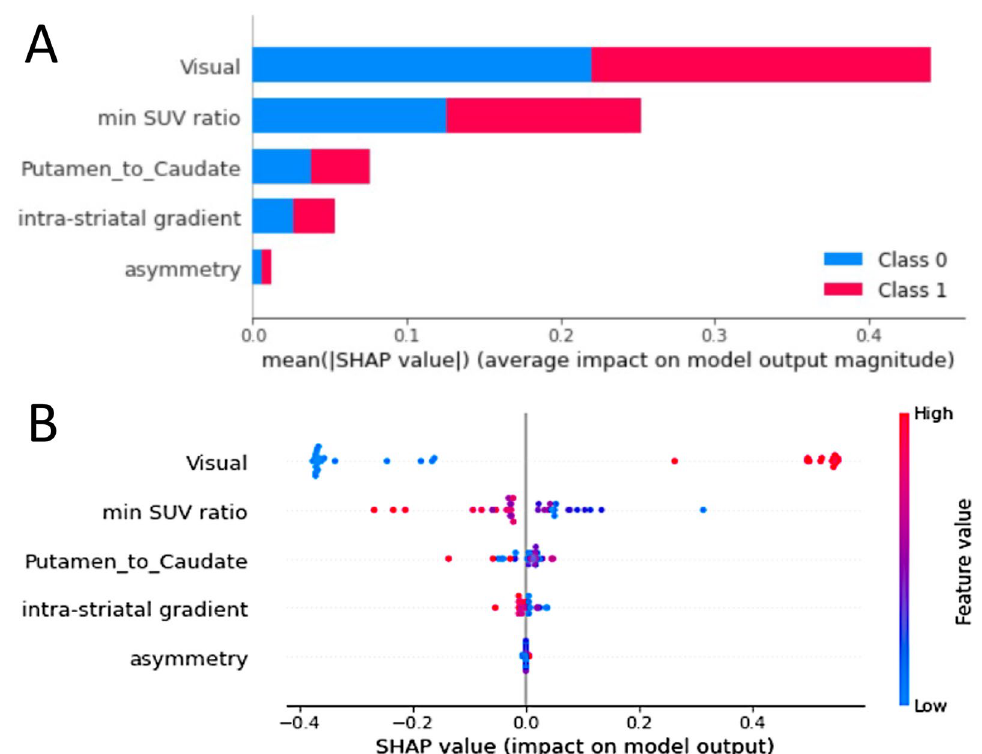
Fig. 7 Shap plot of features’ contribution on the best classifier model output. A Stacked bars of absolute value of the SHAP values for each feature sorted by their importance across all patients for classification. “Class 0” corresponds to the controls and “Class 1” to the IPD group. For classification of IPD versus control, PET visual score is the most contributive parameter, then min SUV ratio is the second most contributive parameter. The three others do not appear relevant for the classification of IPD versus controls here. B SHAP distribution on x -axis of the five features for every patient and control. The impact is correlate to the absolute value of the SHAP value. The higher (redder) feature value, the more it contributes to IPD classification. On the opposite the lower (bluer) feature value, the more it contributes to control classification. Min SUV ratio and intra-striatal gradient are inversely correlated to IPD classification as represent dopamine denervation at different